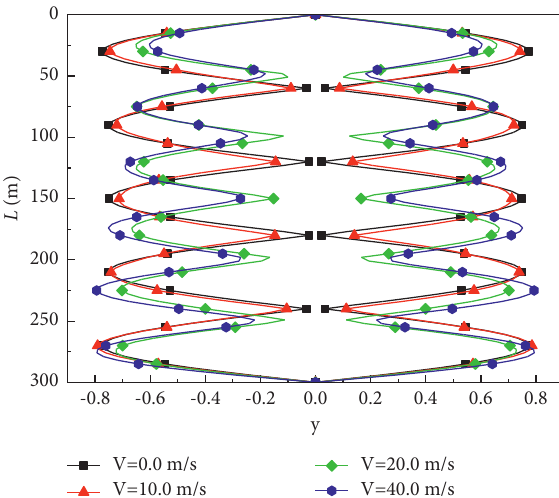
Figure 8: VIV amplitude envelope of risers under different internal flow velocities.